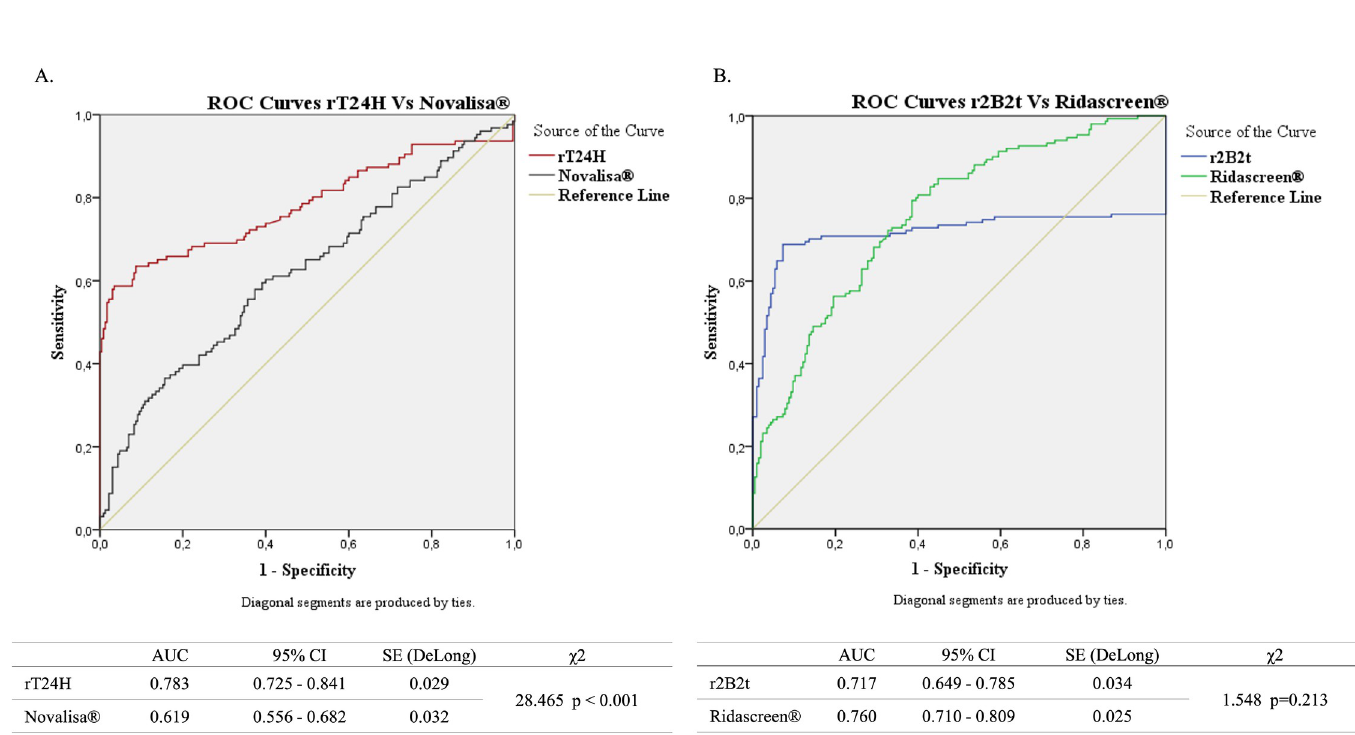
Fig 2. ROC curves analysis of different tests. A.ROC curves analysis showing comparison of rT24H (MBA) and Novalisa (ELISA) with all serum samples sets. B.ROC curves analysis showing comparison of r2B2t (MBA) and Ridascreen (ELISA) with all serum samples sets. Abbreviations: χ 2 :Chi-Square; SE: Standard error; CI: confidence interval; ROC: Receiver Operating Characteristic; AUC: Area under the ROC curve.